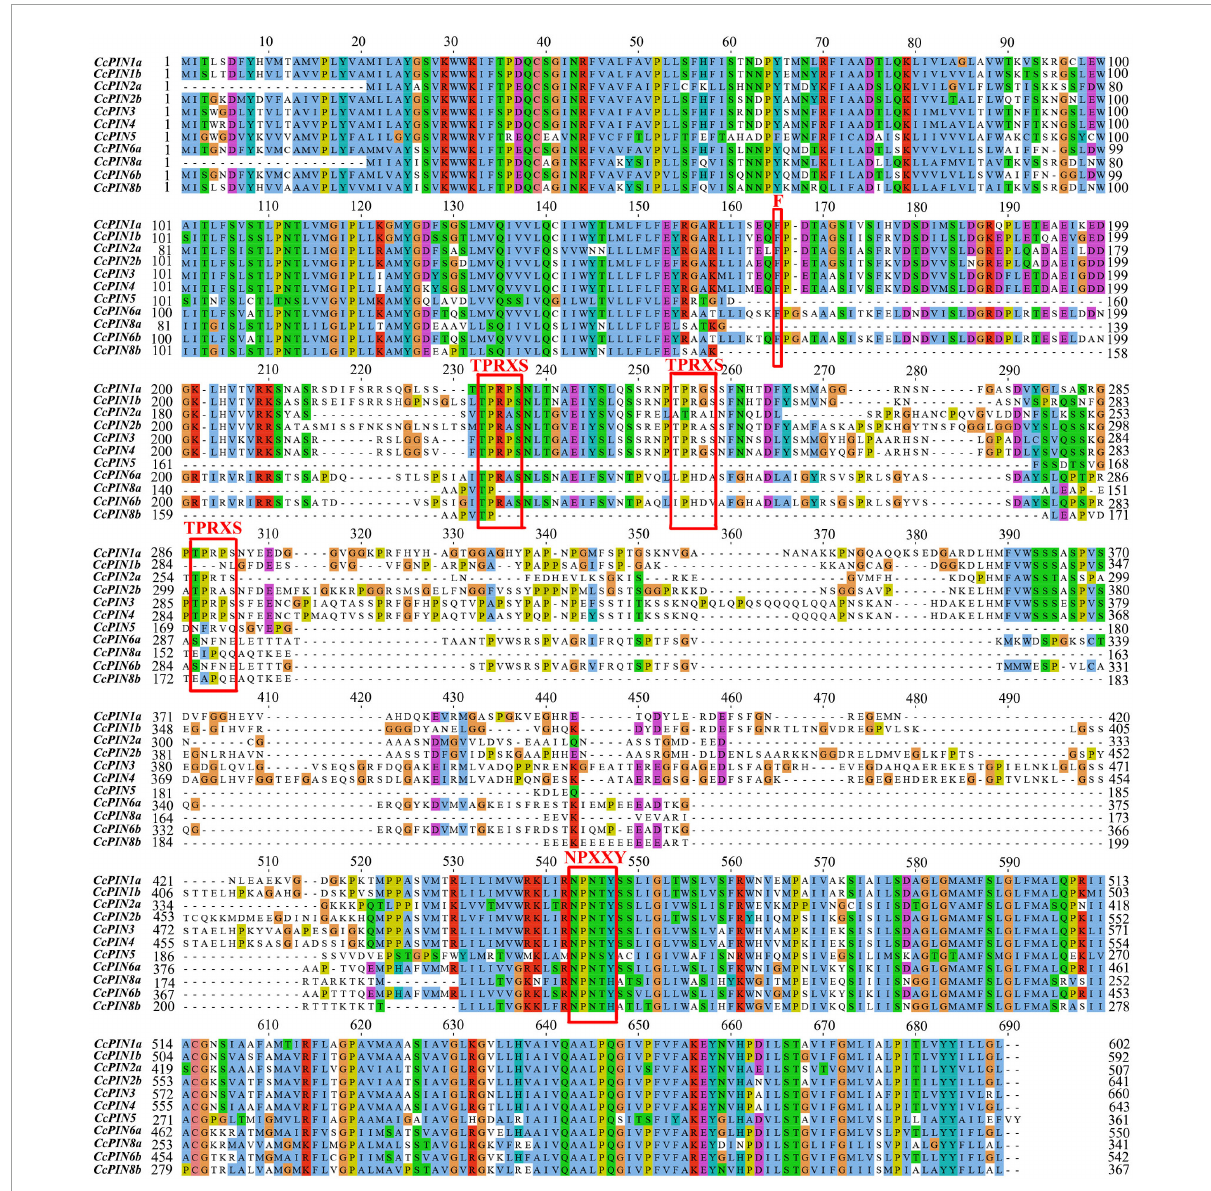
FIGURE3 Multiple alignments of CcPINs by ClustalW. The possible functional sites are circled with red